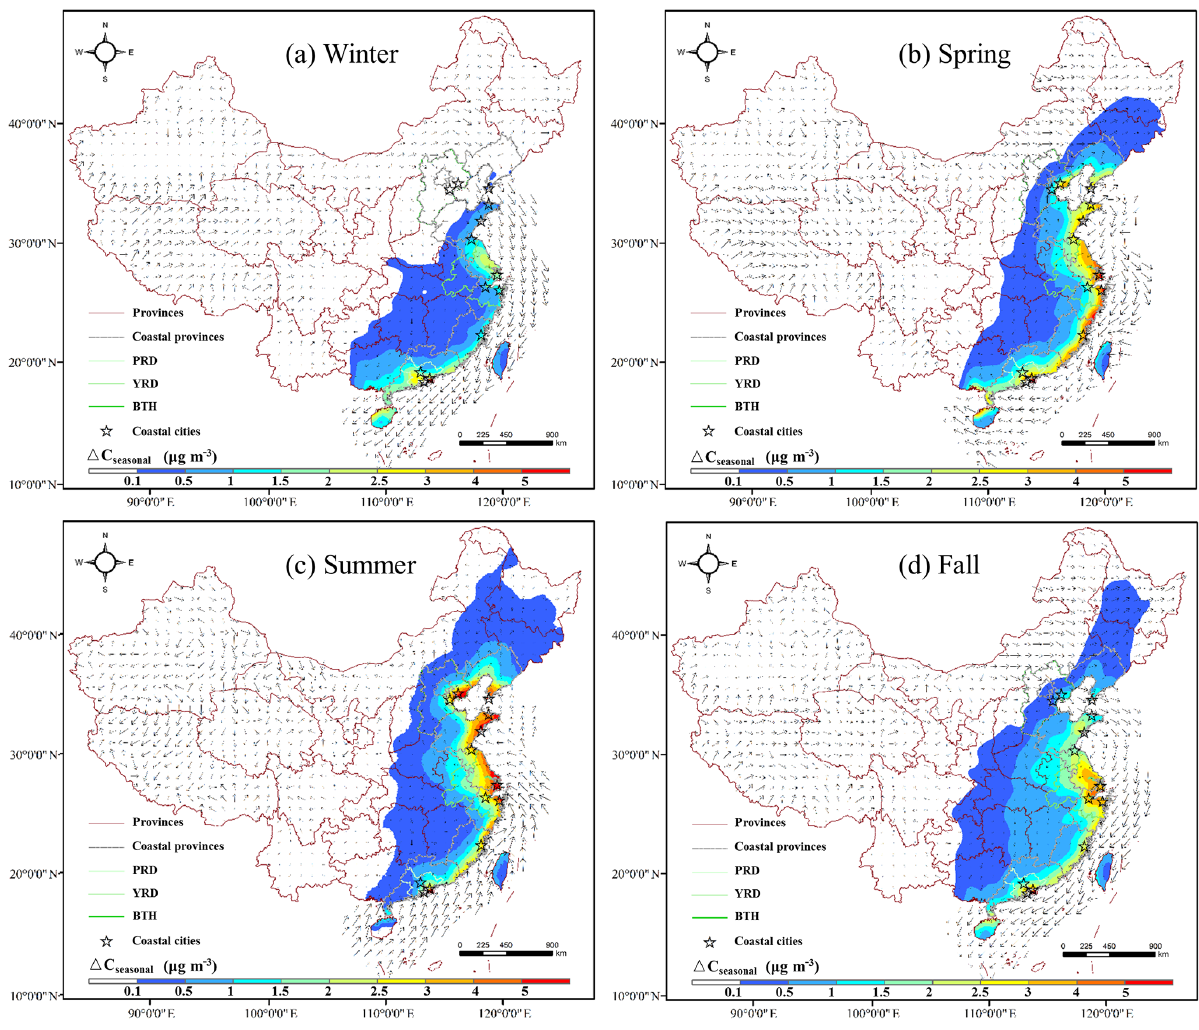
Figure 5. Contributions of shipping emissions to the seasonal mean PM 2 . 5 concentrations (base case- no ship case): (a) winter, (b) spring, (c) summer and (d) fall. Arrows represent the WRF modeled seasonal mean surface wind